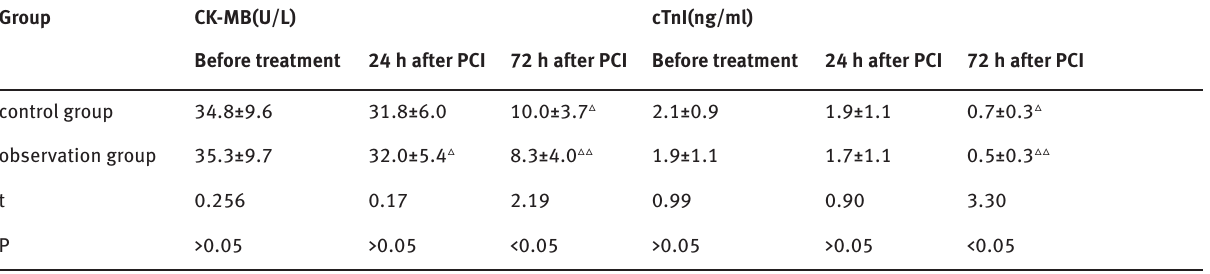
Note: Compared with levels before treatment, Table 3: Cardiac function indexes LVEF and LVDD comparison between both groups Group